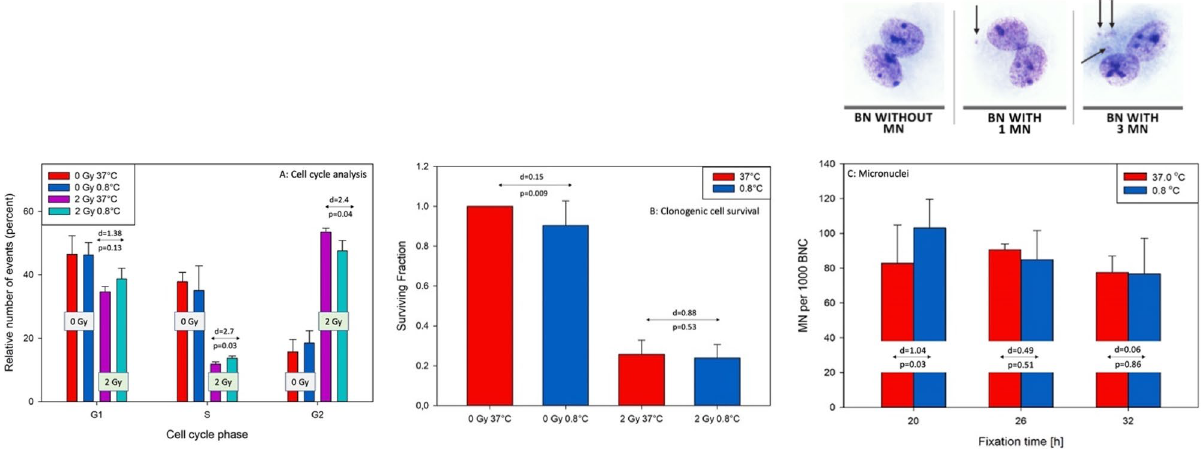
Figure 6. ( A ) distribution of cells in the cell cycle measured by flow cytometry, ( B ) clonogenic cell survival and ( C ) frequencies of micronuclei (MN) in U2OS cells irradiated with 2 Gy at 0.8 °C and 37 °C. See Fig. 1B–D for explanation of the exposure. In micronuclei test cells were harvested at three time points: 20 h, 26 h and 32 h of culture time, following addition of Cytochalasin B directly after irradiation. Error bars represent standard deviations from 3 repeats of cell cycle analyses, 12 repeats of clonogenic cells survival and 6 repeats of MN assay. D values represent Cohen’s d values. p values represent significance level from two-sided Student’s t test, assuming unequal variance. Arrows on images mark